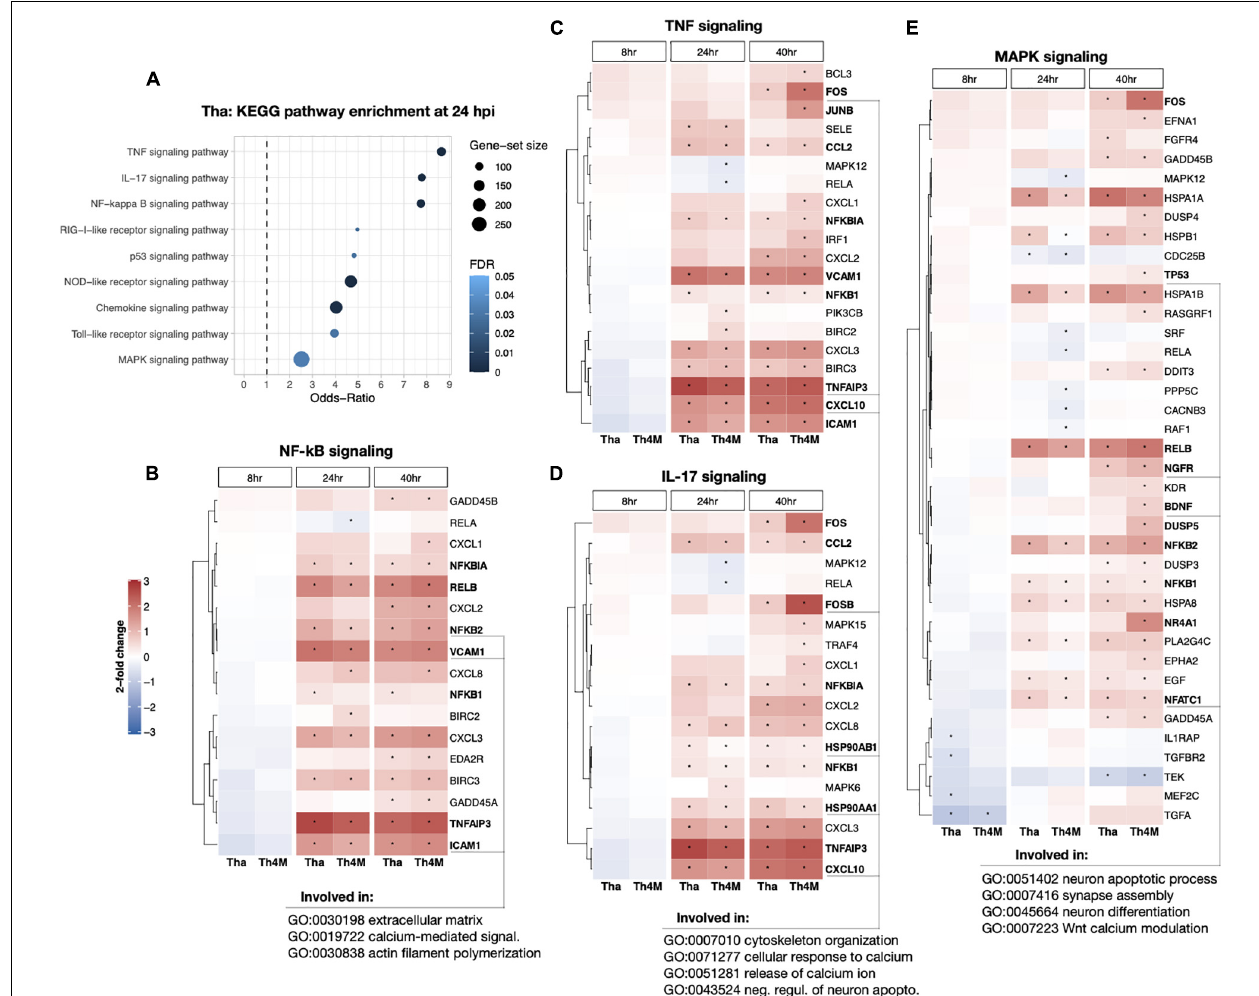
FIGURE 3 | DEG heatmaps of RABV-associated KEGG pathways and the connection to the neuronal function. (A) The relevant KEGG subset was crosschecked with DEGs from 24 hpi Tha dataset, highlighting multiple pathways that are important to cell cycle, differentiation, signal transduction, and immune response among others. (B) DEGs involved in NF-kB signaling (hsa04064) and the expression level indicated in log 2 -fold changes. The time-points of significant selection were marked with black dot. Examples of DEGs and their association with neuronal function-GO terms are underlined at the base of figure. (C) DEGs detected in TNF signaling (hsa04668). (D) DEGs in IL-17 signaling (hsa04657). (E) DEGs detected in MAPK signaling (hsa04010). DEGs validated in RT-qPCR for their expression at 40 hpi (displayed on Figure 4 ) are marked in bold